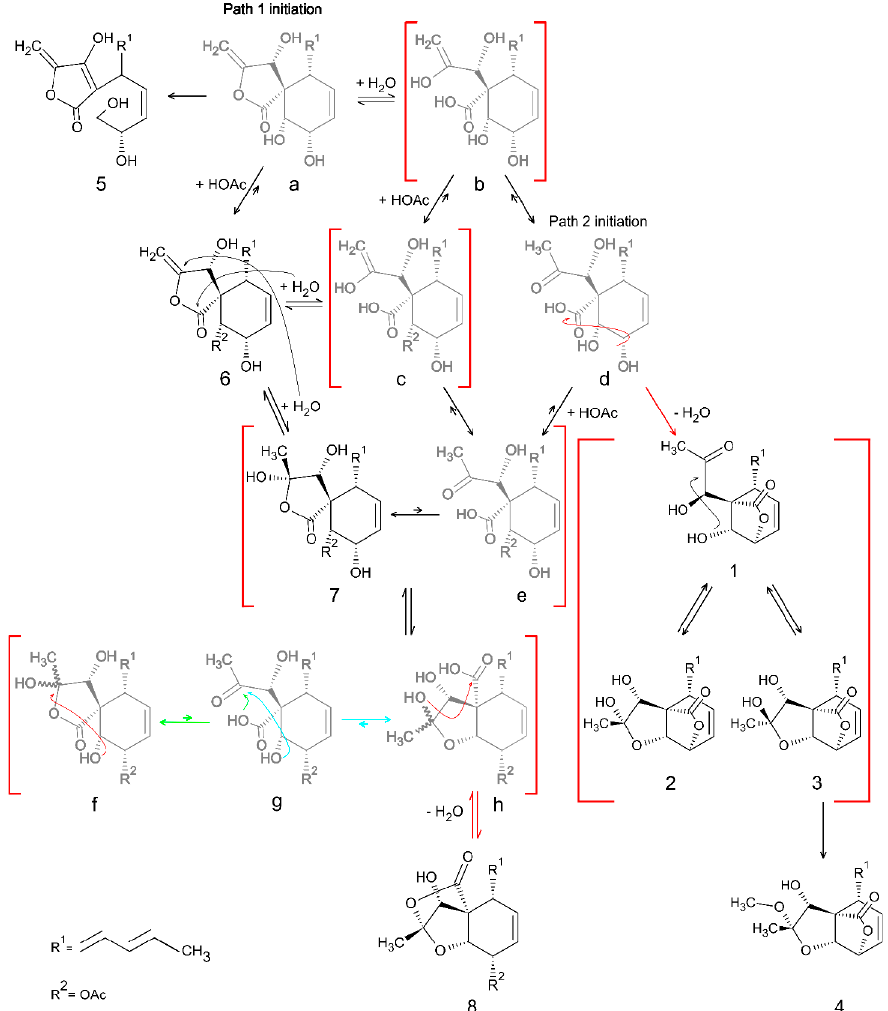
Figure 6. Proposed biosynthetic pathway for compounds 1 – 8 . All faded structures ( a – h ) are hypothetical intermediates which were not observed in this study. Red brackets indicate unstable intermediates or equilibria between compounds existing simultaneously. Equilibrium and reaction arrows are connected to the curved arrows of the respective color.